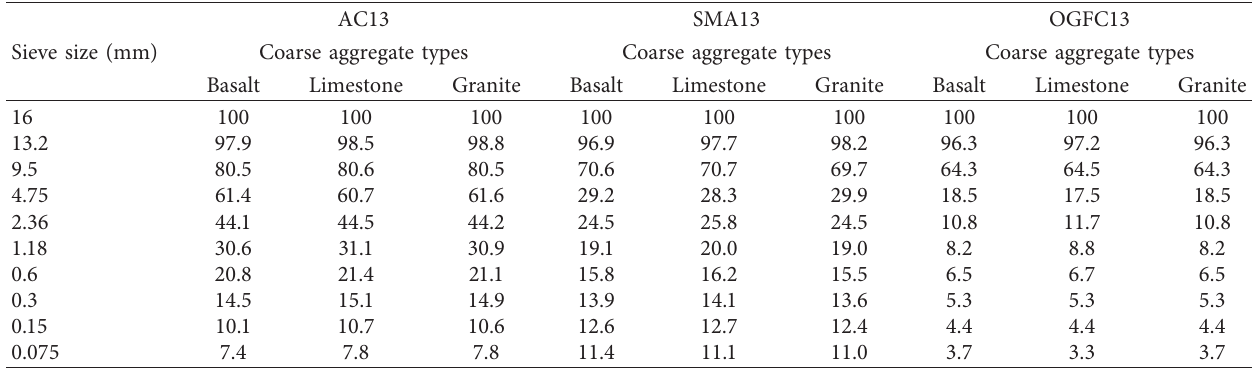
Table 1: The gradation of mineral aggregate of asphalt mixtures.